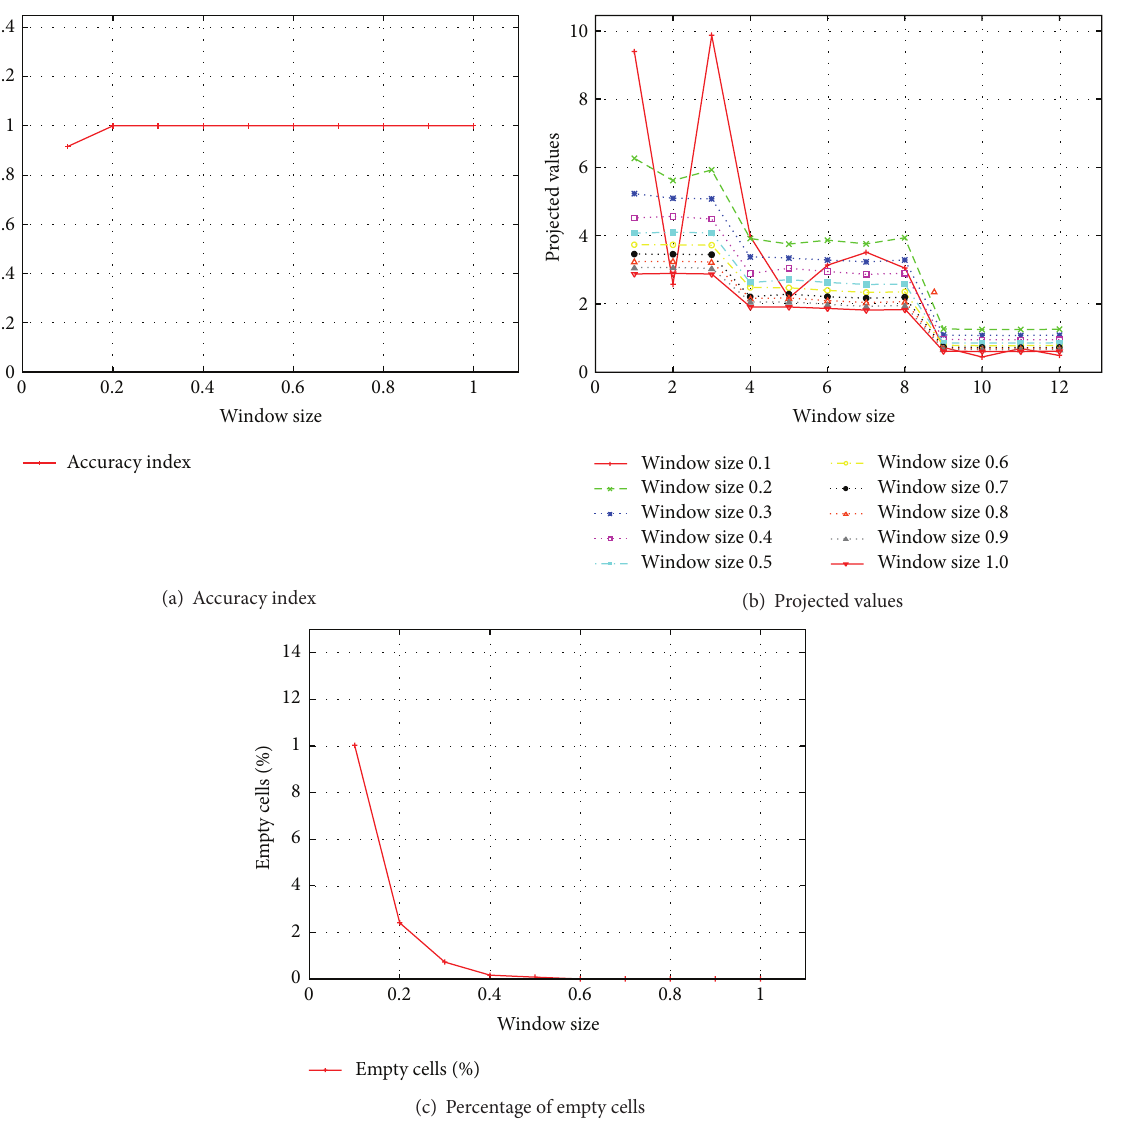
Figure 6: Results of window size